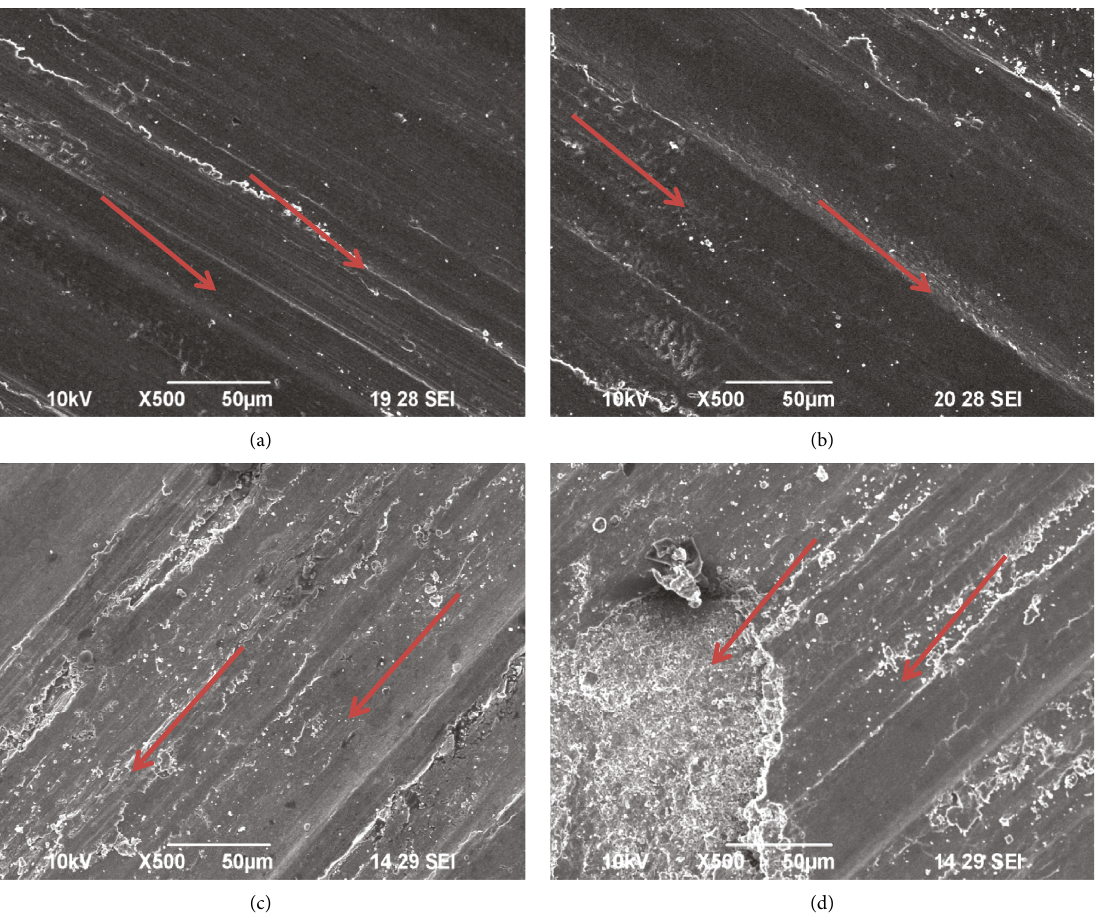
Figure 10: (a) TiC 15%, graphite 3%, and load 10N; (b) TiC 10%, graphite 4%, and load 15N; (c) TiC 5%, graphite 4%, and Load 15N (d). TiC 5%, graphite 45%, and load